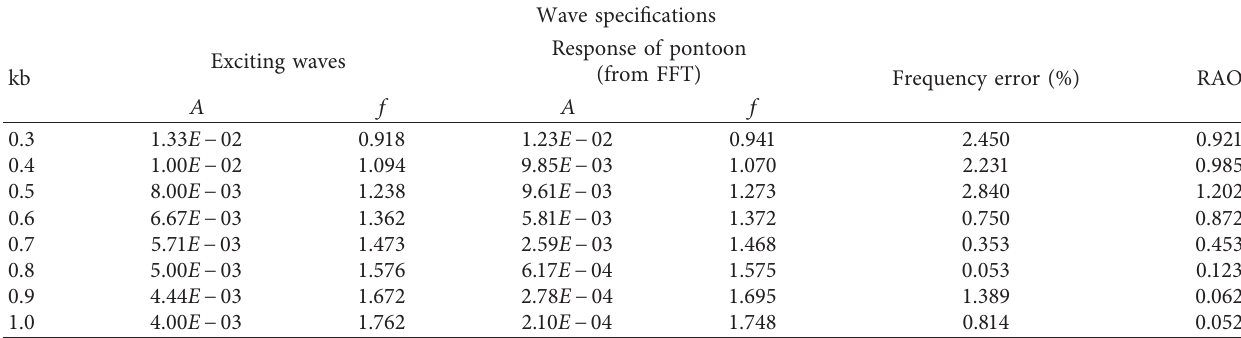
Table 10: Amplitude and frequency of the heaving pontoon for breakwater number 2.